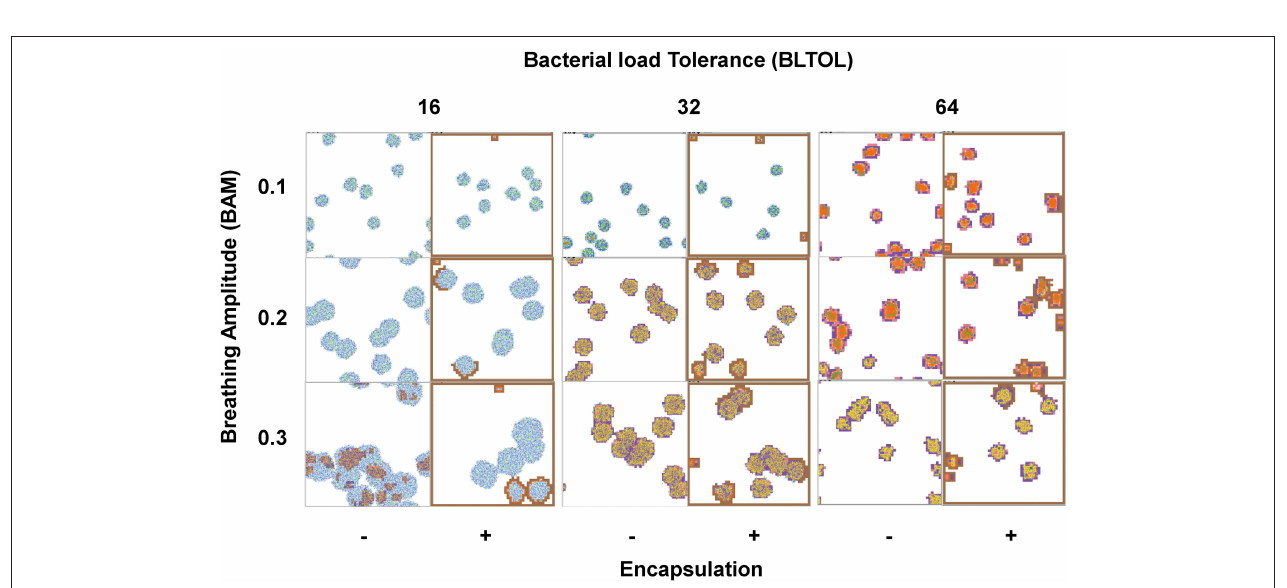
FIGURE 9 | Phenotypical characteristics of the lesions after running the program until day 21 post-challenge. Colors : Alveoli: White : when a single AM is present; Black : when the AM is destroyed; Blue : when the AM is destroyed and replaced by another AM from the interstitium; Violet : when an activated AM (aAM) is present; Pink : when PMNs occupy the alveoli; Brown : capsule. Bacilli: Blue challenge bacilli; Red : Intracellular bacilli (Ibac); Green : Extracellular (Ebac); Brown : growing Ebac; Orange : dormant (Dbac); Yellow : killed bacilli (Kbac).